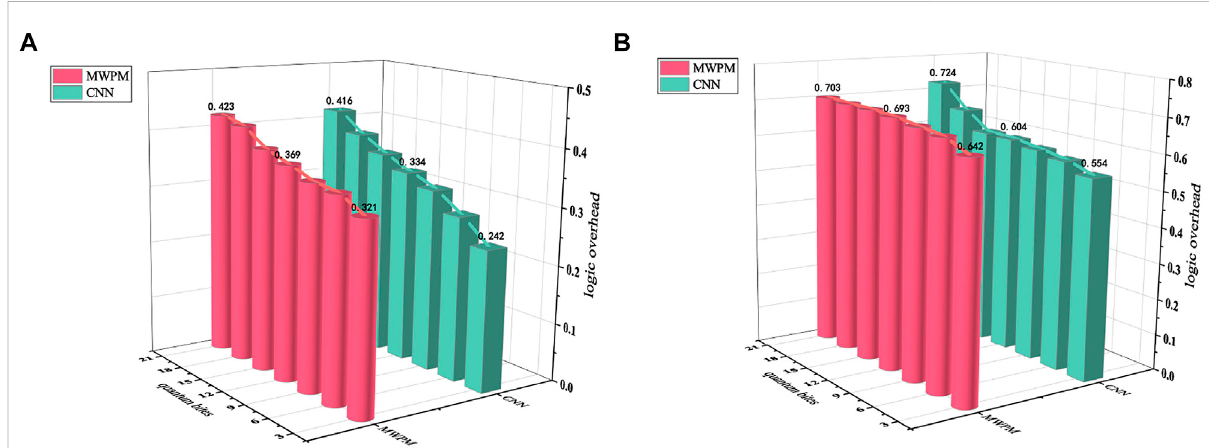
FIGURE 6 Quantum circuit gate overhead data graph. (A) When threshold = 0.005, the cost of MWPM is compared with the optimization cost of CNN network. (B) When threshold = 0.0085, the cost of MWPM is compared with the optimization cost of CNN network. Among them, the abscissa represents the number of qubits, displayed in scienti fi c notation, and the ordinate is the logical cost. The cost of CNN is marked in pink, and the cost of CNN optimization is marked in